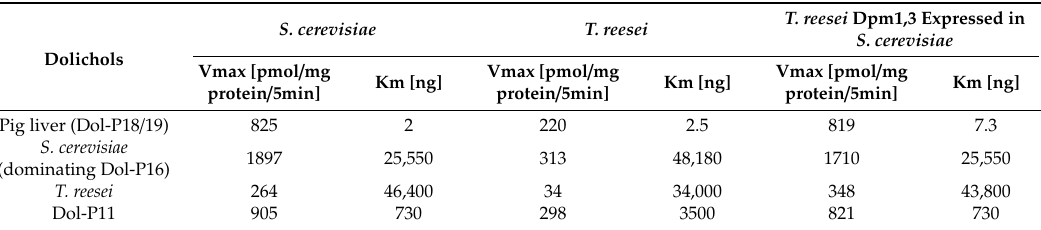
Table 2. Kinetic parameters of dolichyl phosphate mannose synthase from S. cerevisiae and T. reesei for di ff erent dolichol